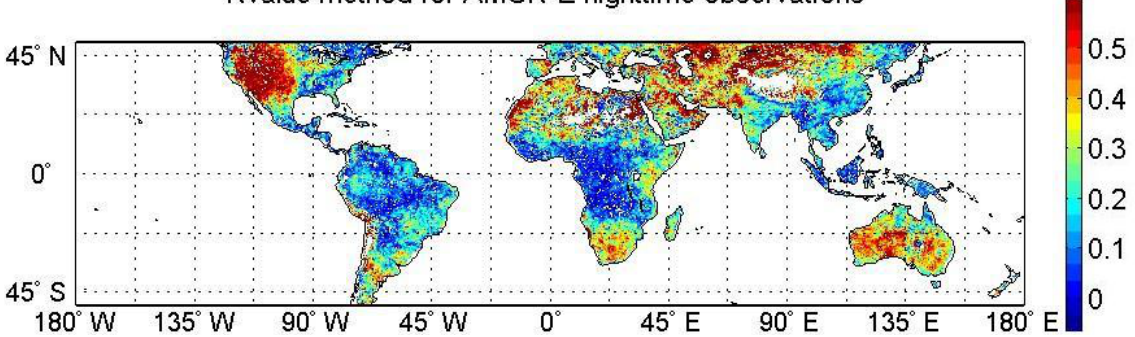
Fig. 4. Example of the R value method for the AMSR-E descending overpass, the analysis period was February 2003 till December 2010. Red areas indicate high R value outputs and blue areas indicate low R value